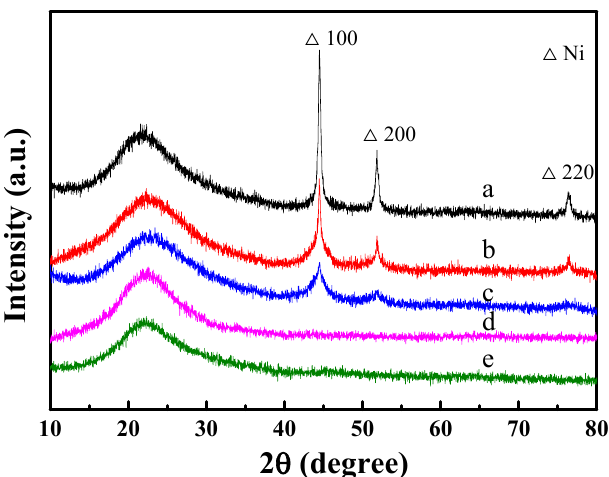
clear diffraction peaks at 2 θ values of 37 ◦ , 43 ◦ , 62 ◦ , and 74.5 ◦ were obtained for Ni/SiO 2 and Ni-G-2/SiO 2 -C (Figure 1a,b), attributed to the (111), (200), (220), and (311) cubic NiO Figure 1. X-ray diffraction patterns of the as-prepared Ni/SiO 2 ( a ), Ni-G-2/SiO 2 -C ( b ), Ni-G-1/SiO 2 - planes, respectively [34,39]. The diffraction peaks of Ni-G-2/SiO 2 -C were significantly P ( c ), Ni-G-2/SiO 2 -P ( d ), and Ni-G-3/SiO 2 -P ( e ) catalysts. weaker than Ni/SiO 2 , indicating that relatively smaller-sized NiO nanoparticles were formed on the Ni-G-2/SiO 2 -C catalyst because the Ni 2+ complexed with glycine during the Since metallic Ni is the active species for the CDR, the Ni particle size was also char- impregnation process. Catalyst Ni-G-1/SiO 2 -P showed even weaker peaks of cubic NiO acterized by X-ray diffraction after reducing the catalysts at 700 o C for 2.5 h, and the results diffraction, at 2 θ values of 37 ◦ , 43 ◦ , and 63 ◦ , whereas no observable peaks of Ni species are shown in Figure 2. All the reduced catalysts exhibited the diffraction peaks of amor- were obtained for Ni-G-2/SiO 2 -P and Ni-G-3/SiO 2 -P. These observations indicate that Ni phous silica, suggesting that the SiO 2 support did not change by the reduction conditions. species were dispersed well in Ni-G/SiO 2 -P than Ni-G/SiO 2 -C and Ni/SiO 2 . The better In addition, the characteristic diffraction peaks of metallic Ni with different intensities dispersion occurs due to the increased viscosity of the impregnating solution caused by were obtained at 2 θ values of 44°, 52°, and 76° for Ni/SiO 2 , Ni-G-2/SiO 2 -C, and Ni-G- the addition of glycine that suppresses the outward flow of the solution, leading to a more 1/SiO 2 -P, indicating that the NiO reduced to Ni at the reduction conditions [39]. However, uniform distribution of Ni species inside the pores of the support [36,41,42]. Moreover, no diffraction peaks of Ni species were observed for Ni-G-2/SiO 2 -P and Ni-G-3/SiO 2 -P, the formation of the Ni complex prevents the aggregation of Ni particles during the high- suggesting that particle sizes were too small to be detected by XRD. These results demon- temperature calcination process, affording smaller NiO particles [41], and therefore, no strate that the Ni particle size was significantly influenced by the preparation method and obvious diffraction peaks were observed in XRD. the amount of glycine used.